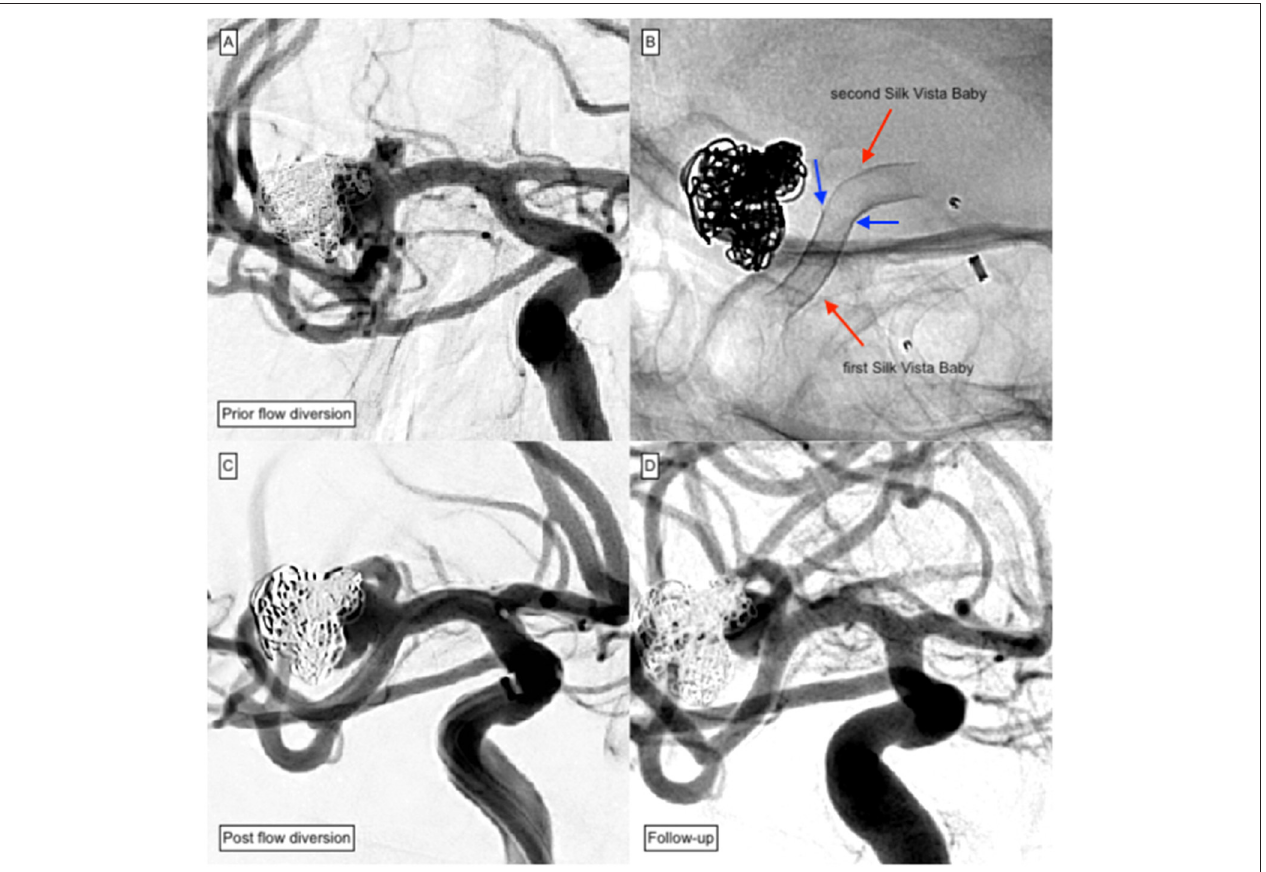
FIGURE 4 | Plug and Pipe treatment of a previously ruptured MCA aneurysm of the right-handed side. Due to the difference in diameter between the M1 and M2 segments, extensive proximal shortening occurred after implantation of the first SVB and required complementary implantation of a second SVB. (A) DSA of a non-ruptured saccular aneurysm located at the right-handed side MCA bifurcation after protective coiling shows significant reperfusion and coil compaction. Decision was made for retreatment with SVB. (B) The first implanted SVB had shortened proximally (blue arrows) and did not sufficiently cover the aneurysm. Consequently, implantation of an additional device in telescoping technique was performed. (C) The control injection showed the timely opacification of all MCA branches including the covered superior truncus. (D) To avoid ischemic complications, DAPT was extended to 16 months. However, a significant remnant was observable at 15 months follow-up.